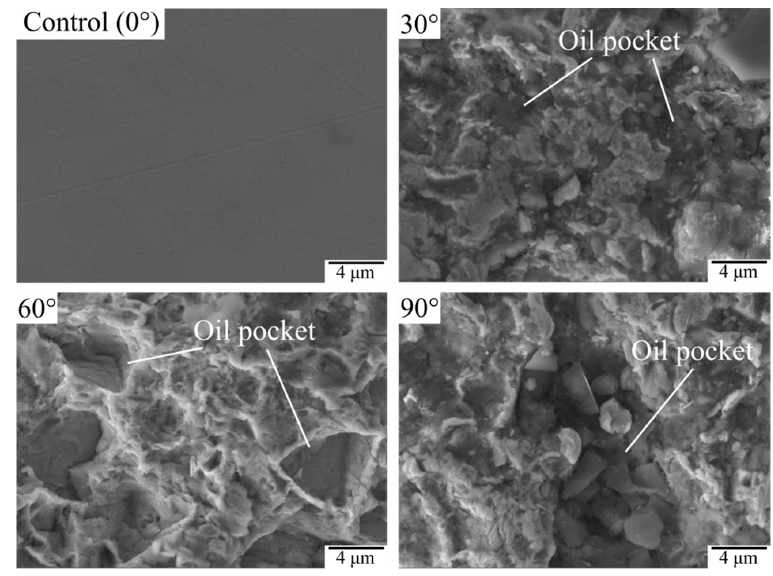
Figure 14. Microscope morphology of the oil pocket. Table 3. The oil storage capacity of oil pockets at different jet angles of